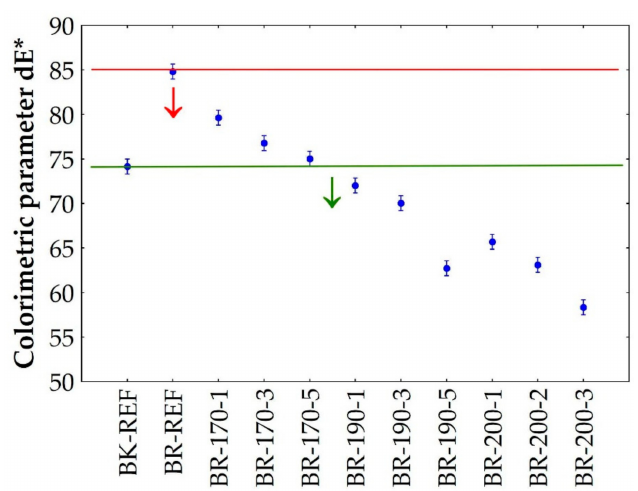
Figure 9. The graphic visualization of the e ff ect of heat-treatment temperature and heat-treatment time limit (peak stage) on colorimetric parameter dE* (total color di ff erence) with label the necessary shift of values from the untreated birch (red line) below the values of the untreated beech (green line). BK-REF = untreated beech; BR-REF = untreated birch; BR-170-1 = birch treated at 170 ◦ C / 1 h; BR-170-3 = birch treated at 170 ◦ C / 3 h; BR-170-5 = birch treated at 170 ◦ C / 5 h; BR-190-1 = birch treated at 190 ◦ C / 1 h; BR-190-3 = birch treated at 190 ◦ C / 3 h; BR-190-5 = birch treated at 190 ◦ C / 5 h; BR-200-1 = birch treated